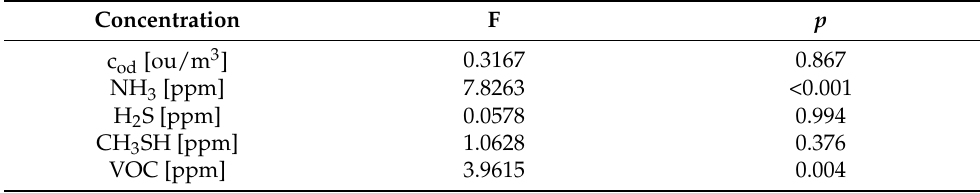
Table 4. One-way ANOVA results of concentration values grouped by the number of the series. Concentration